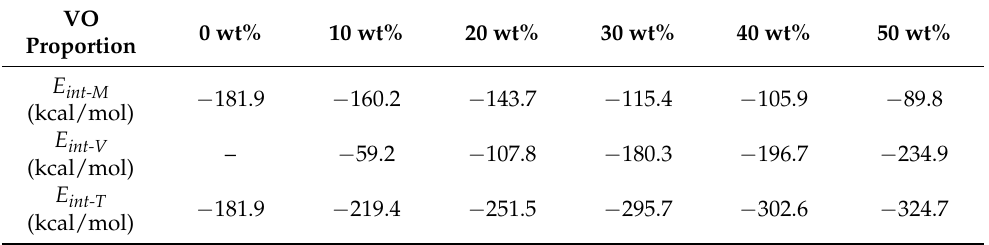
Table 12. Interaction energy between mixed oil and water molecules with 2 wt% of water content. VO